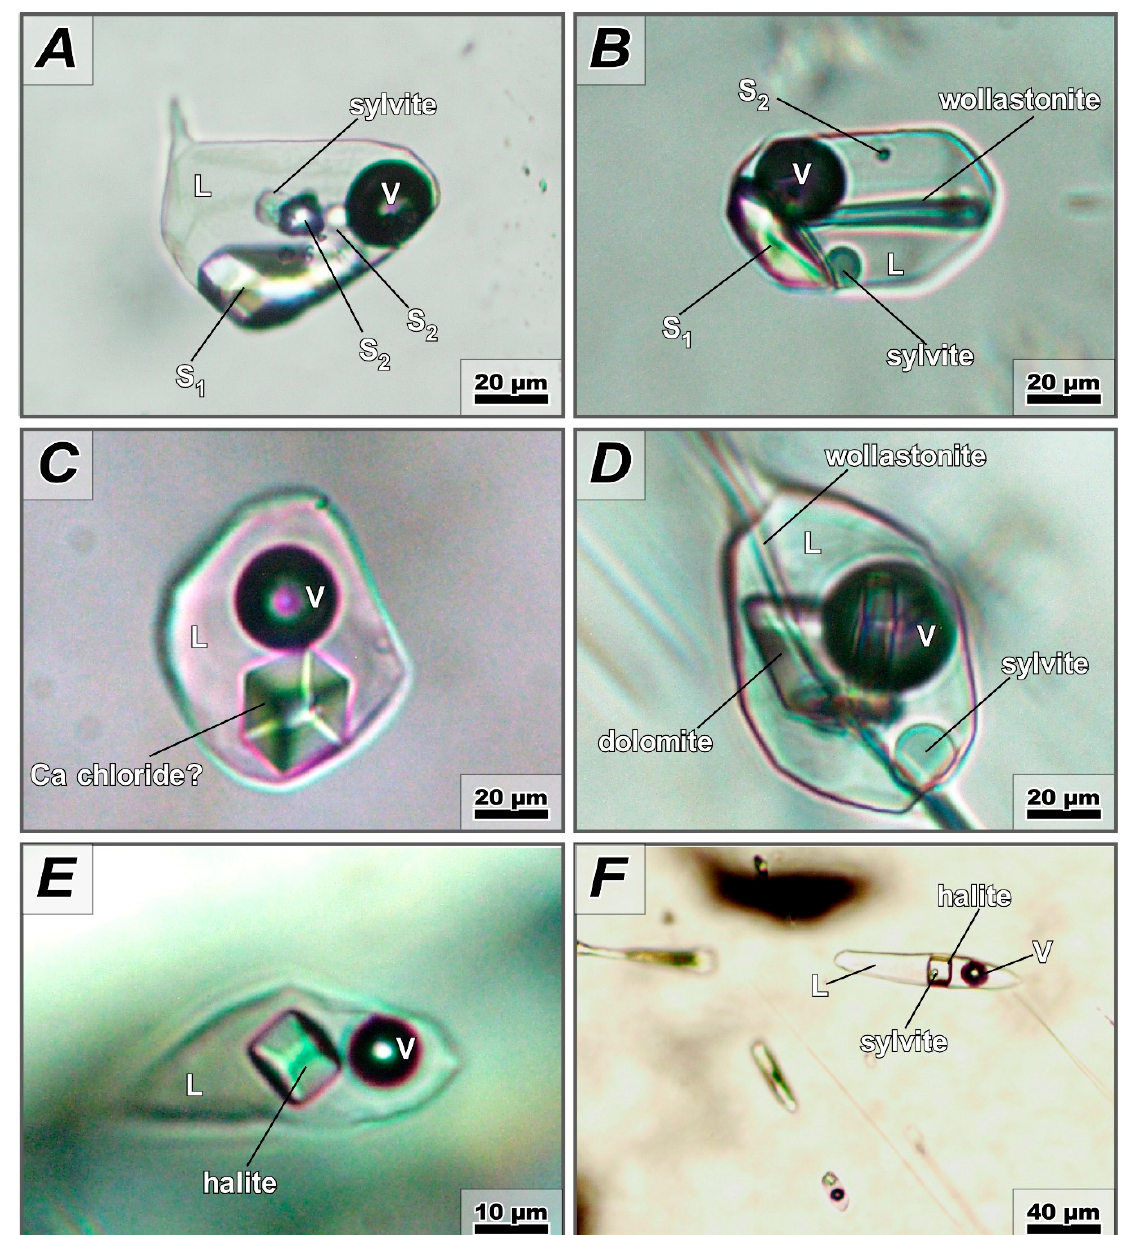
Figure 9. Photomicrographies of representative multiphase fluid inclusions from the El Pilote fluorite skarn, showing trapped solids (wollastonite, dolomite, and unknown phases S 1 , S 2 and S 3 ; A , B , D ) and daughter crystals (halite, sylvite and possible hydrophilite; A to F ).